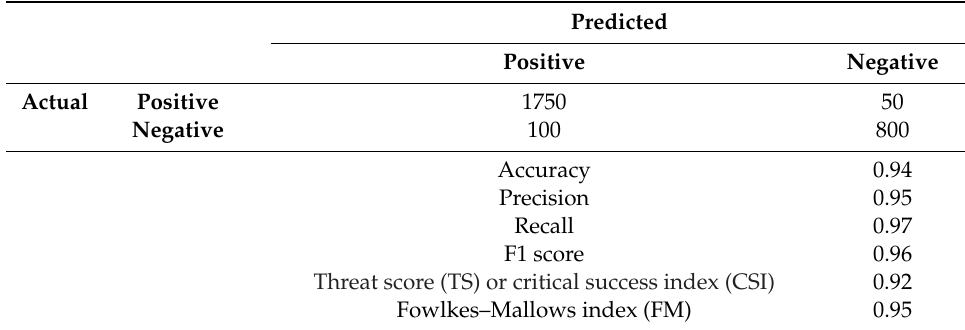
Table 3. Confusion matrix of prediction based on